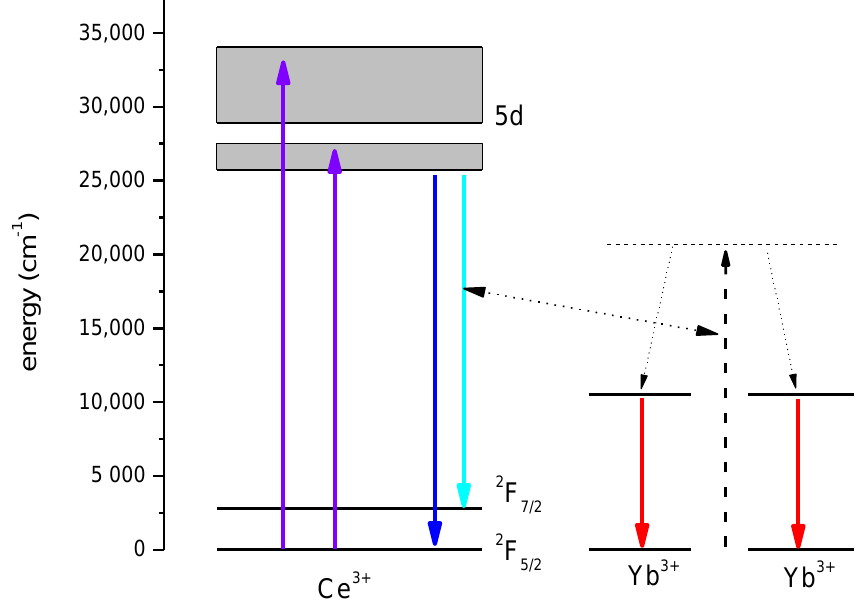
Figure 12. Energy levels of Ce 3+ and Yb 3+ in YAG.